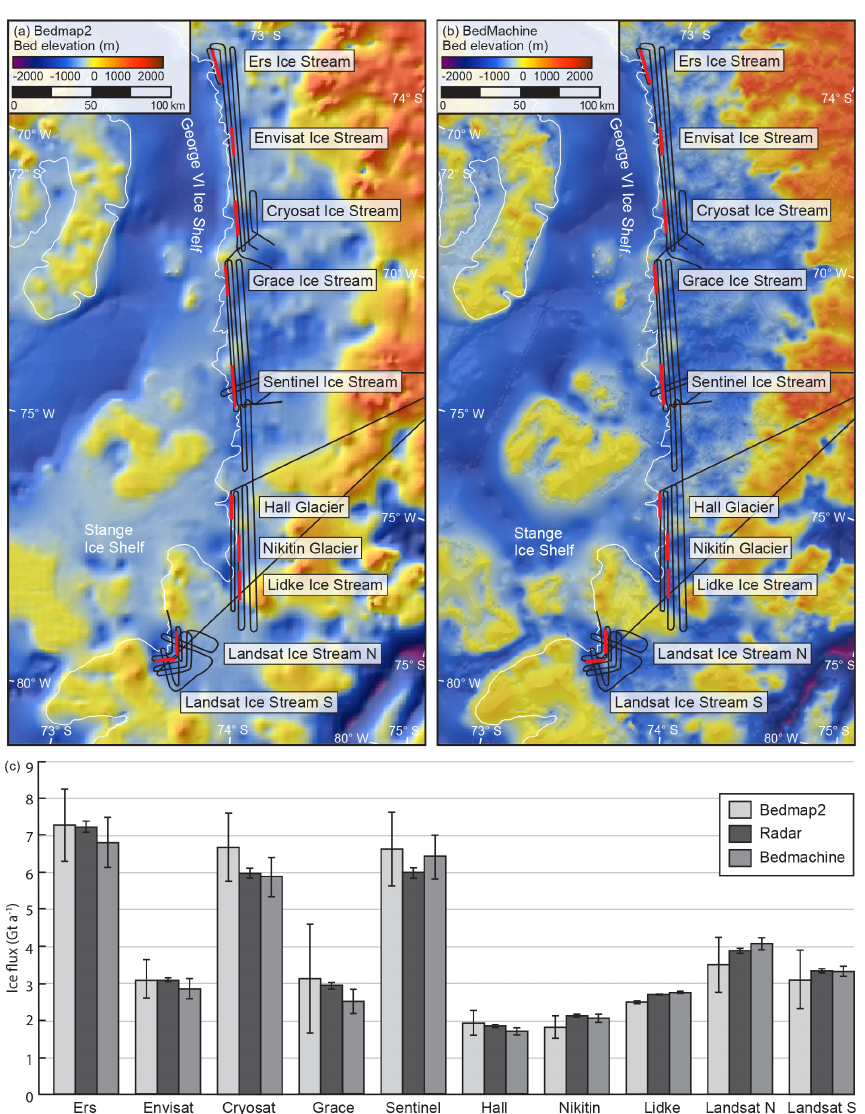
Figure 2. Major outlet glacier and ice stream flux gates (red) along the English Coast of Palmer Land. Subglacial topography maps from Bedmap2 (Fretwell et al., 2013) and BedMachine (Morlighem, 2019) are presented in panels (a) and (b) . Black lines denote airborne RES transects detailed in this paper, whilst the white line shows the location of the ASAID grounding line (Bindschadler et al., 2011). Both maps show that subglacial topography frequently rests well below sea level along the English Coast. Panel (c) compares ice flux measurements (in metric gigatons), derived from Bedmap2 ice thickness data (Fretwell et al., 2013) (light-grey bars), our direct radar measurements (dark-grey bars), and ice thickness data from BedMachine (Morlighem, 2019) (mid-grey bars). These calculations utilize the same flux gates, noted in panels (a) and (b)